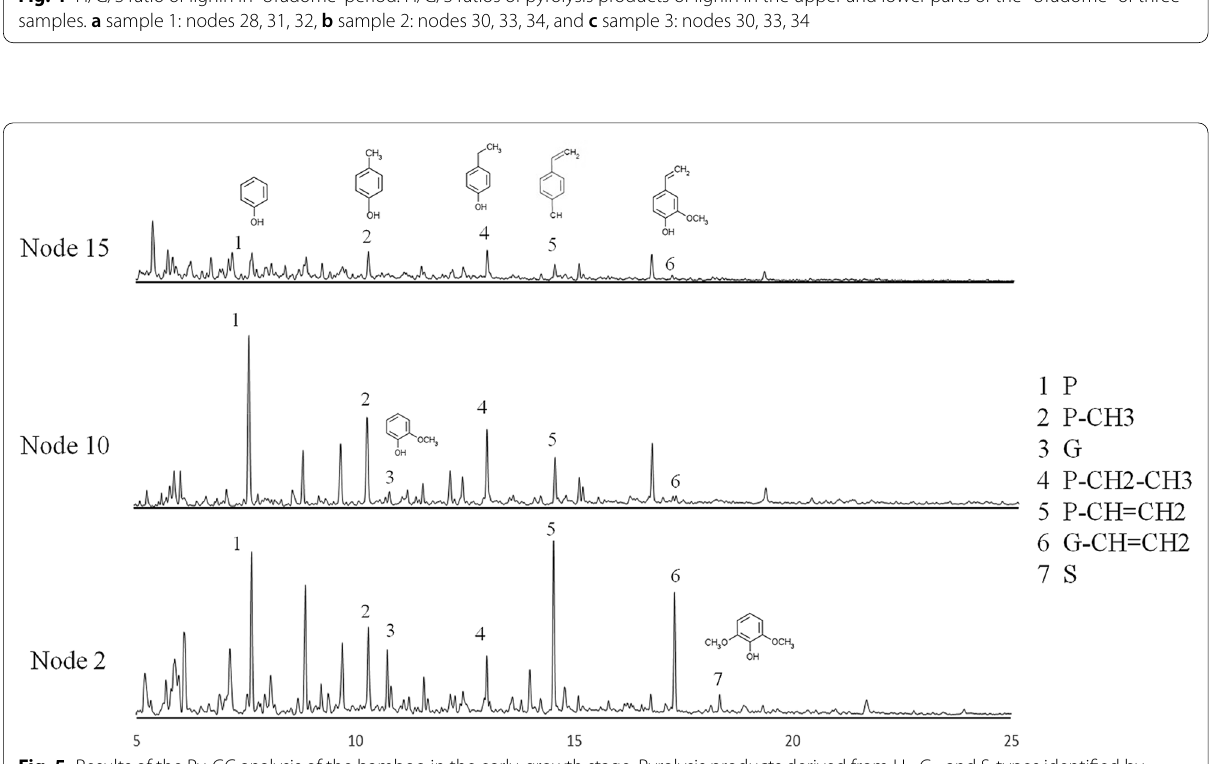
Fig. 5 Results of the Py‑GC analysis of the bamboo in the early‑growth stage. Pyrolysis products derived from H‑, G‑, and S‑types identified by Py‑GC analysis of each node in the early‑growth